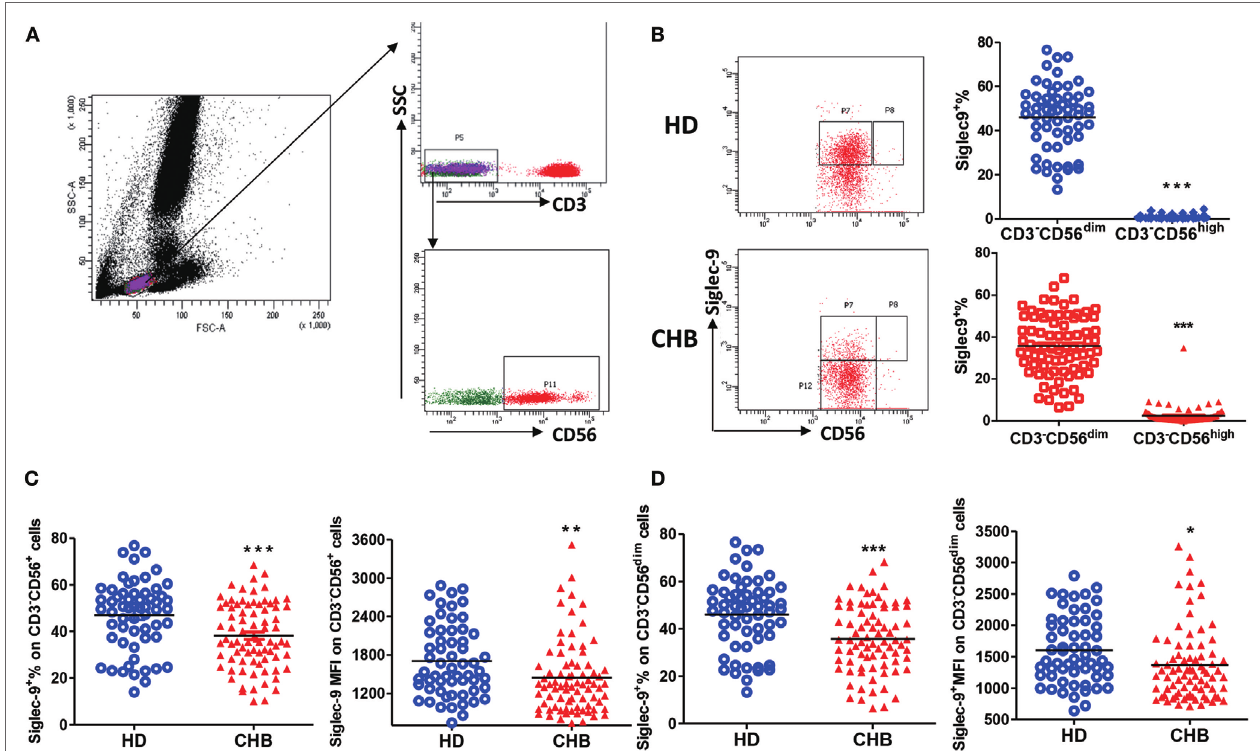
FigUre 1 | Decreased Siglec-9 expression on NK cells from chronic hepatitis B (CHB) patients. (a) The gating strategy for identification of lymphocytes, CD3 − cells, and CD3 − CD56 + NK cells. (B) The percentage of Siglec-9 expression on CD3 − CD56 dim NK cells and CD3 − CD56 high NK cells from both healthy donors (HDs) and CHB patients. Representative dot plots were shown in left panels. (c) The percentage and mean fluorescence intensity (MFI) of Siglec-9 expression on CD3 − CD56 + NK cells. (D) The percentage and MFI of Siglec-9 expression on CD3 − CD56 dim NK